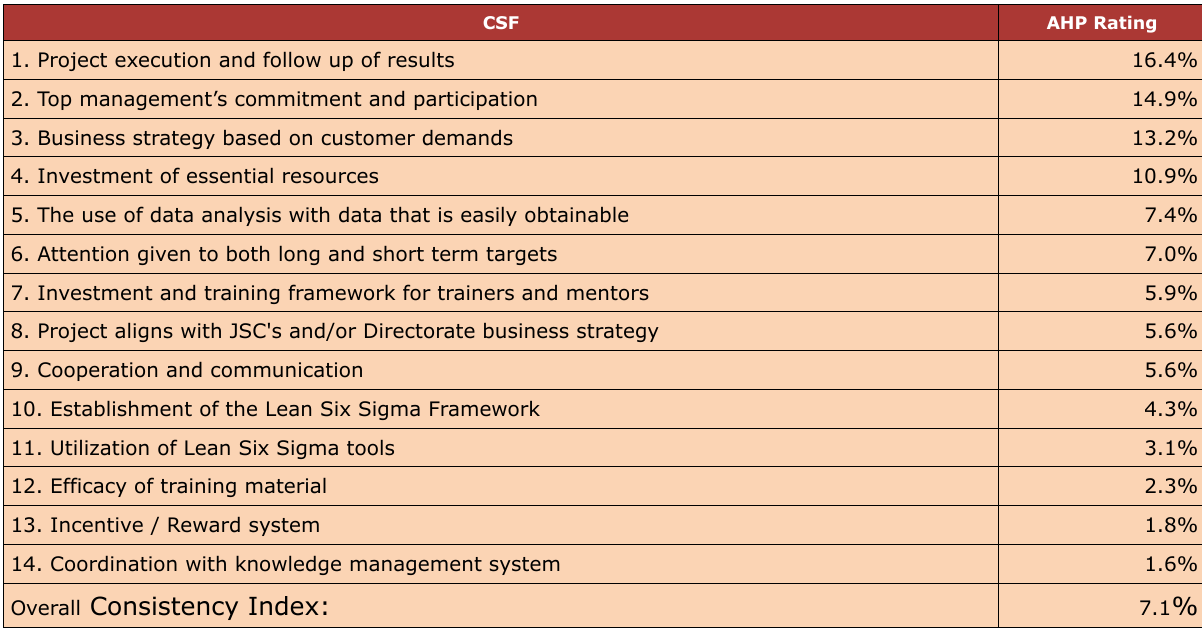
Table 4. Final CSF